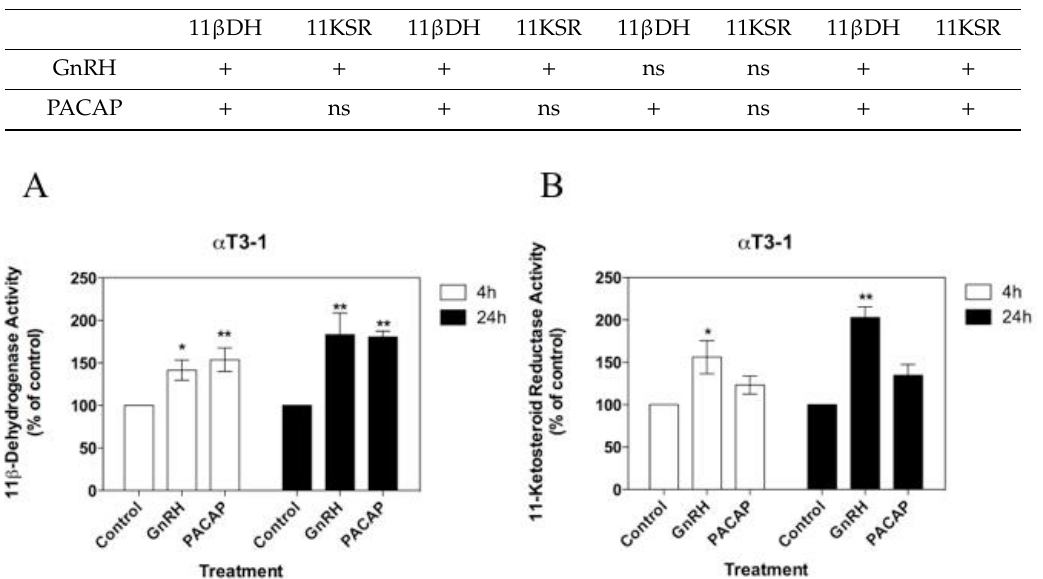
Figure 3. E ff ects of GnRH and PACAP on ( A ) 11 β -dehydrogenase and ( B ) 11-ketosteroid Figure 3. Effects of GnRH and PACAP on ( A ) 11β -dehydrogenase and ( B ) 11-ketosteroid reductase